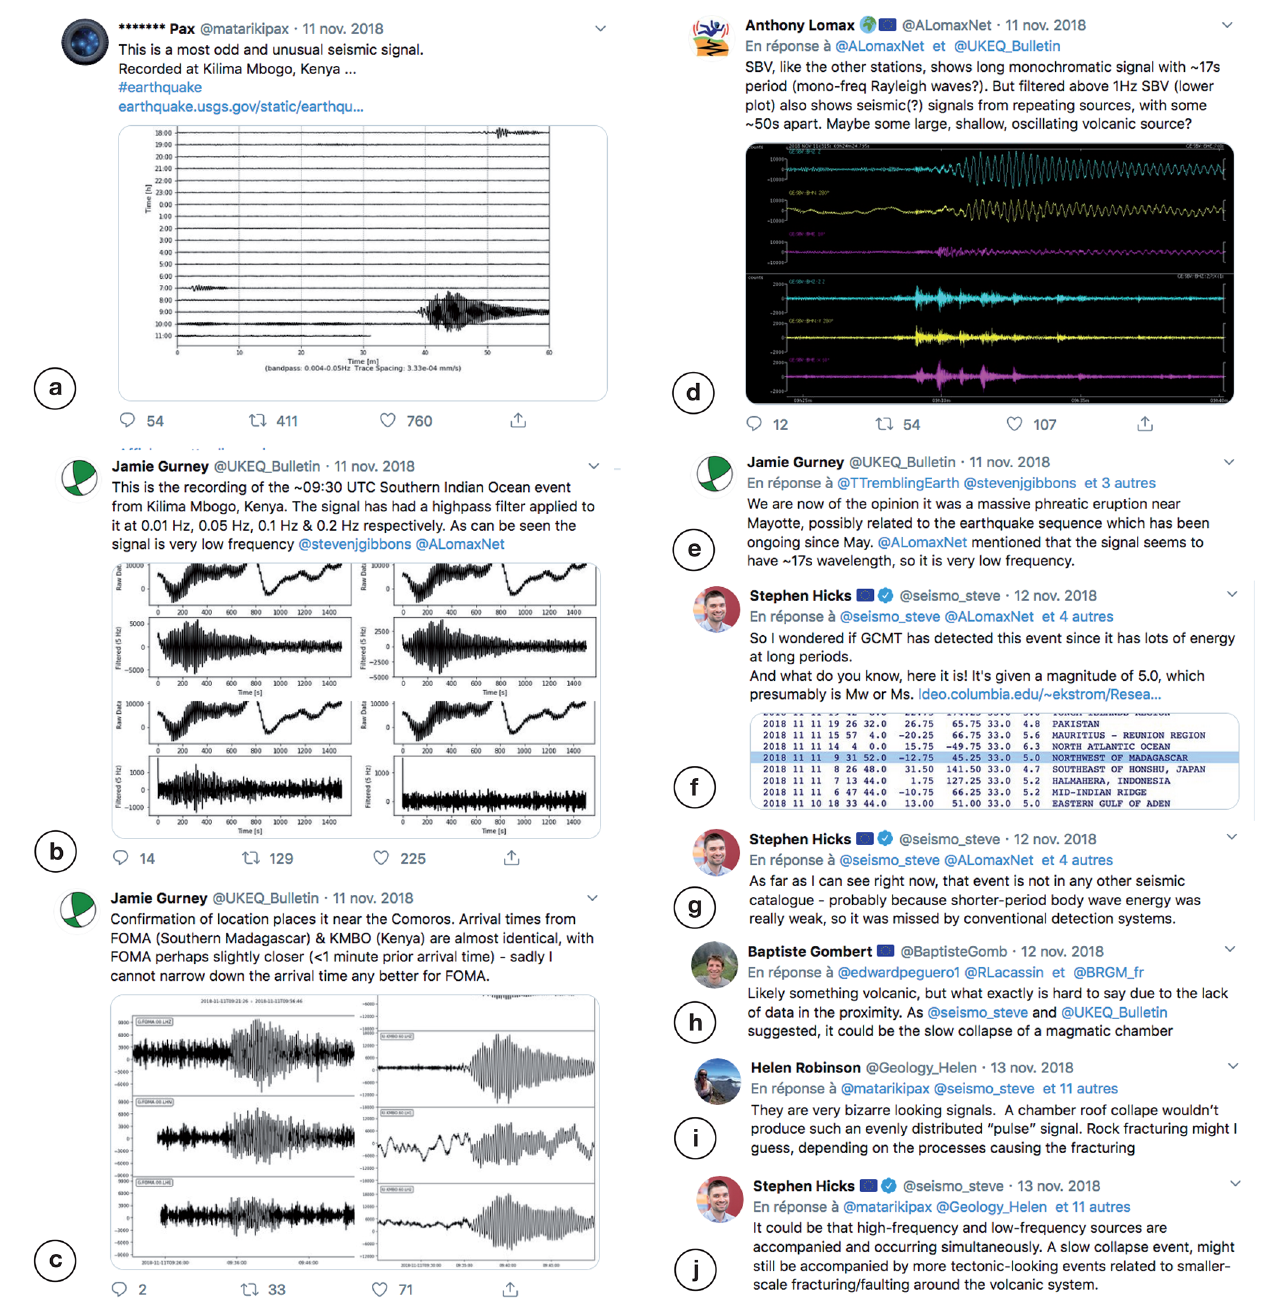
Figure 4. Screenshots illustrating early Twitter exchanges about the very long-period seismic signal near Mayotte on 11 November 2018. The selected screenshots show that Twitter discussion was initiated by citizen scientists (a–c) and then progressively involved academic researchers (d–f) . Those researchers then started an active discussion about the seismic signal and its possible origin (e–j)